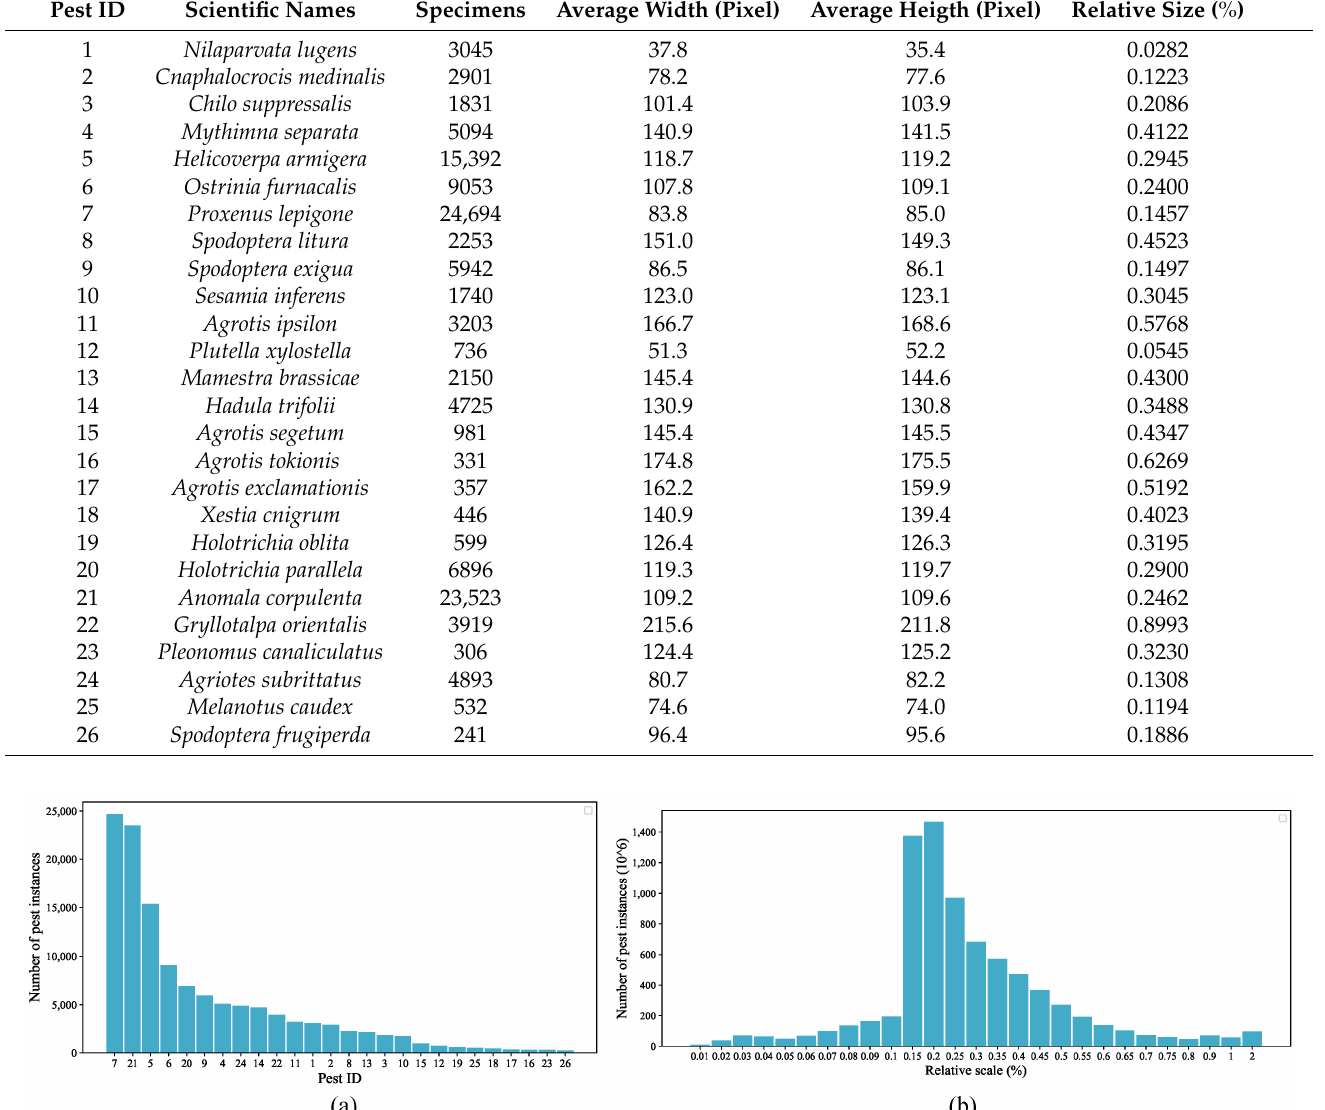
Table 1. The statistics of the MPD2021 dataset.